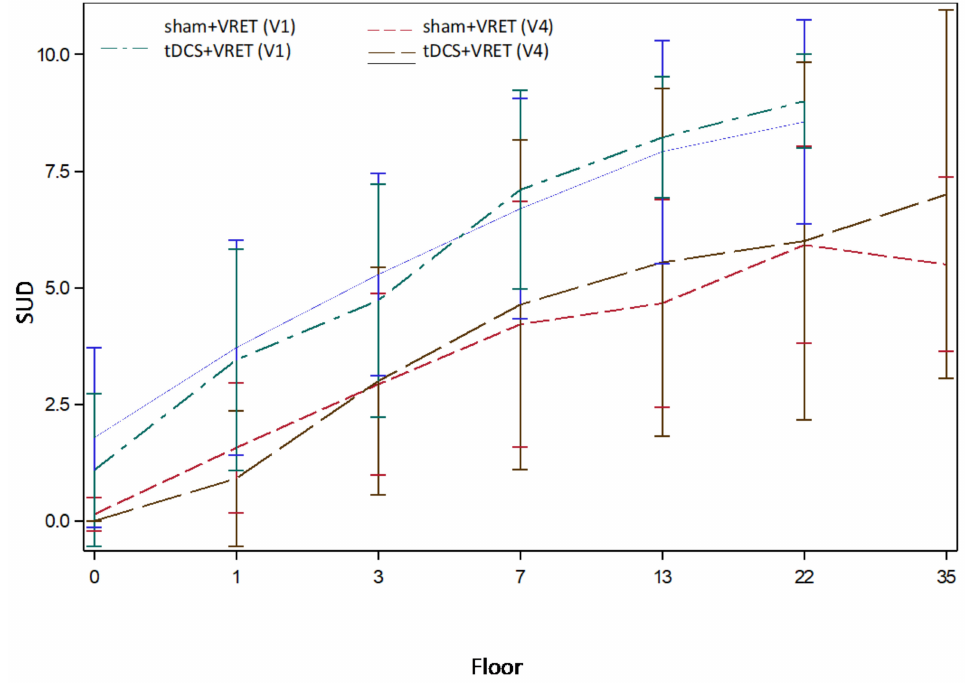
Figure 7. SUD score evolutions according to floor elevations during VRET. Abbreviations: SUD: Subjective Unit of Discomfort; VRET: Virtual Reality Exposure